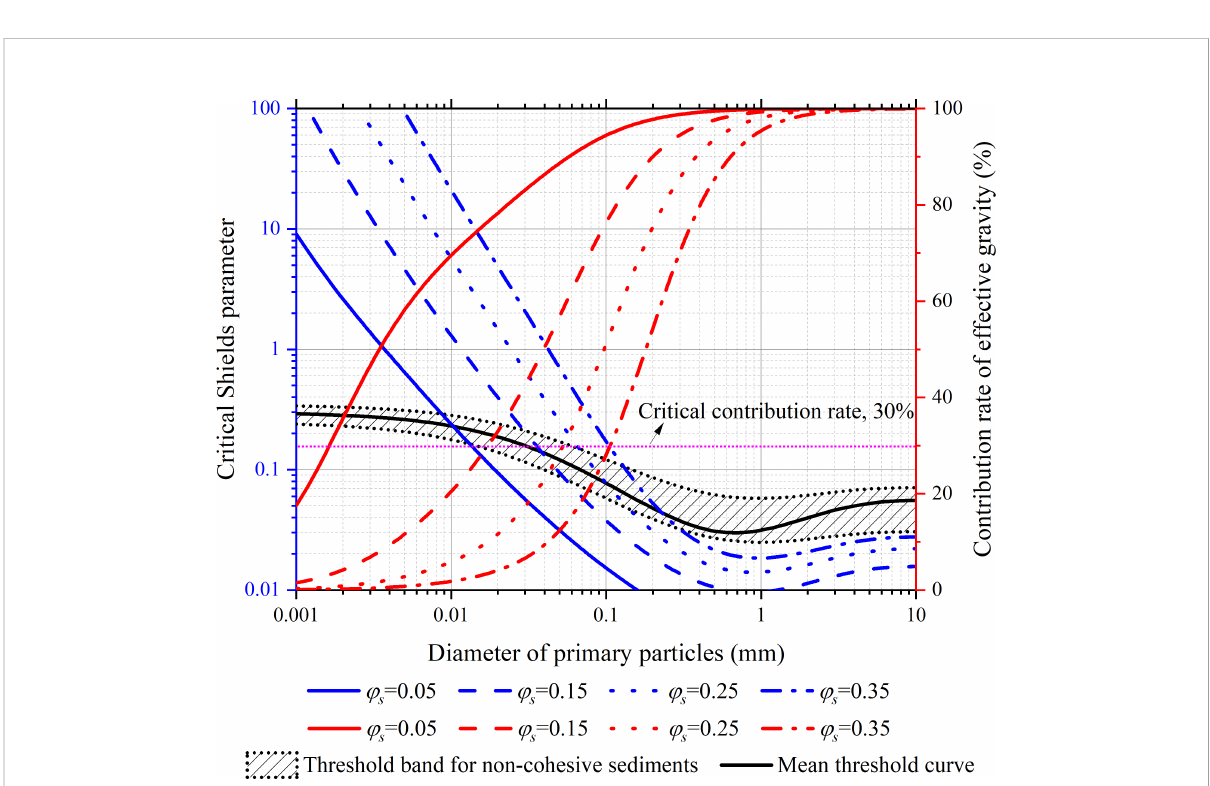
FIGURE 9 The critical Shields parameter and contribution rate of effective gravity of aggregate versus diameter of primary particles and solid volume